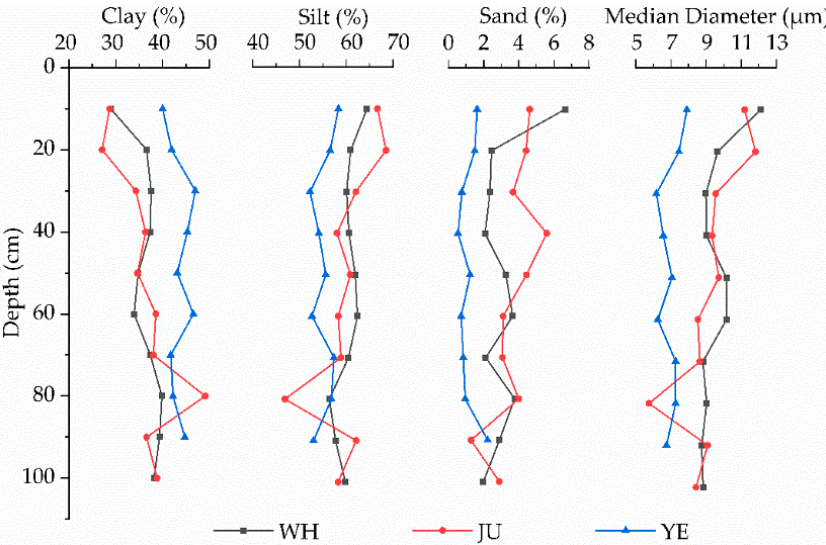
Figure 4. Particle size distribution of the Wuhan (WH), Jiujiang (JU), and Yueyang (YE) profiles. Each datum is the average of three measurements.